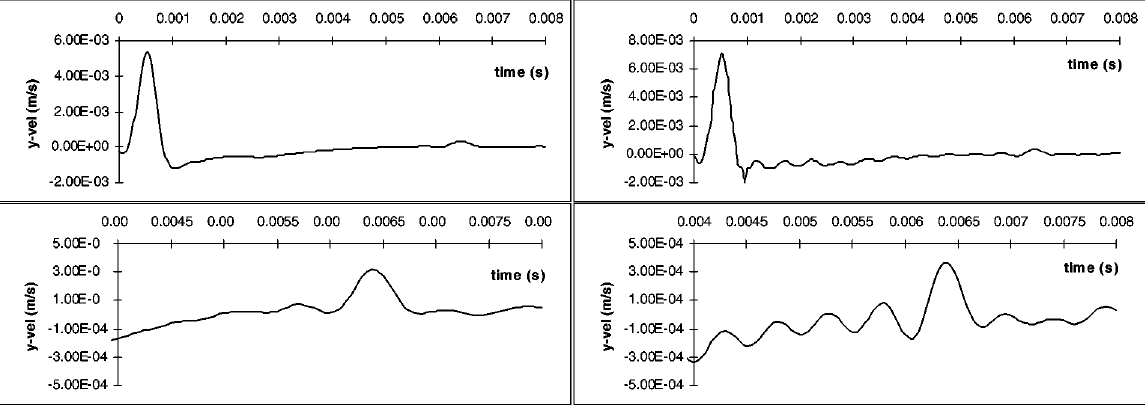
Fig. 3. Wavelet (left) and Fourier (right) filtered traces for finite element generated pile test data.